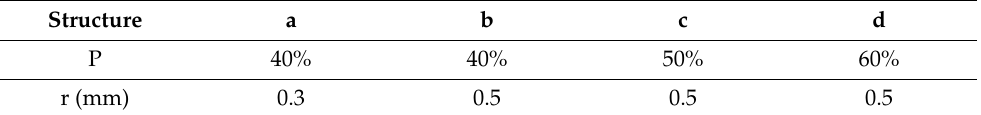
Table 4. Structures with target porosity and target average pore radius.